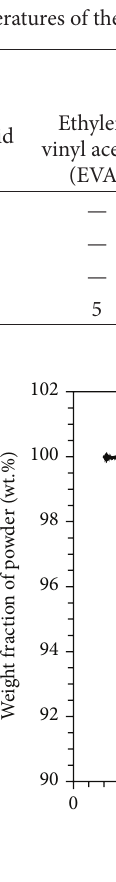
feedstock produce, respectively, a single-plateau and a multi- plateau TGA curve. Weight loss starts between 150 and 225 ∘ C. The binder is completely burned over a temperature range of about 300–500 ∘ C depending on the feedstock